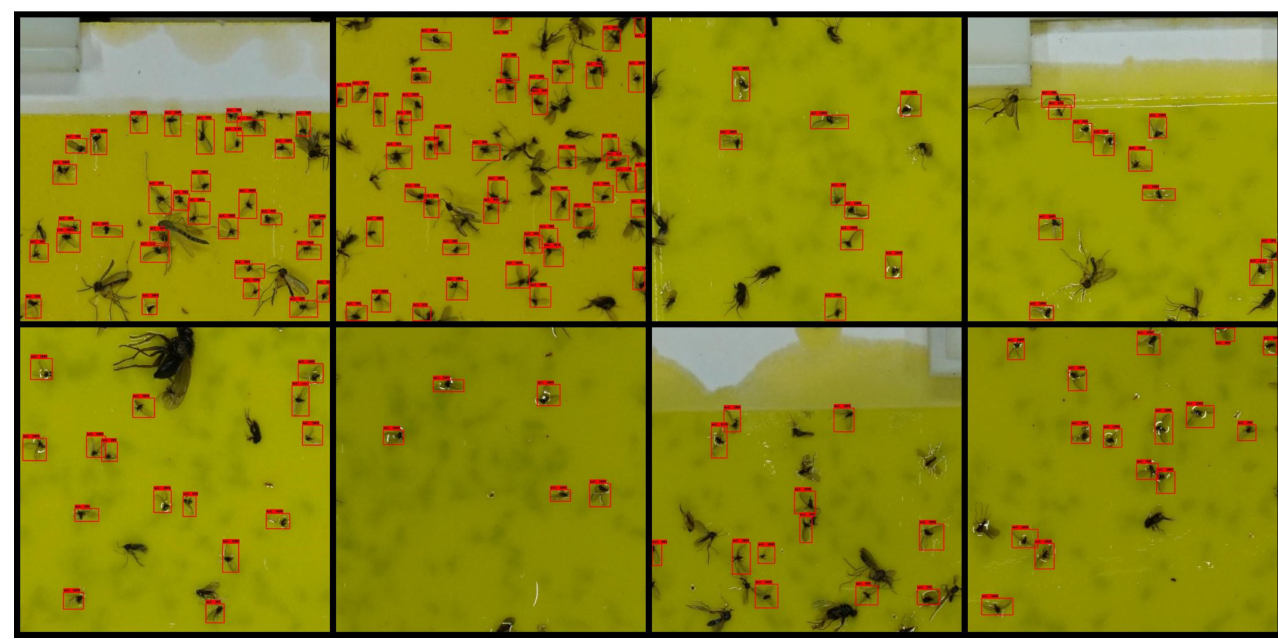
Figure 8. Detection result images of the 6 × 4 cropping condition (0.5 score